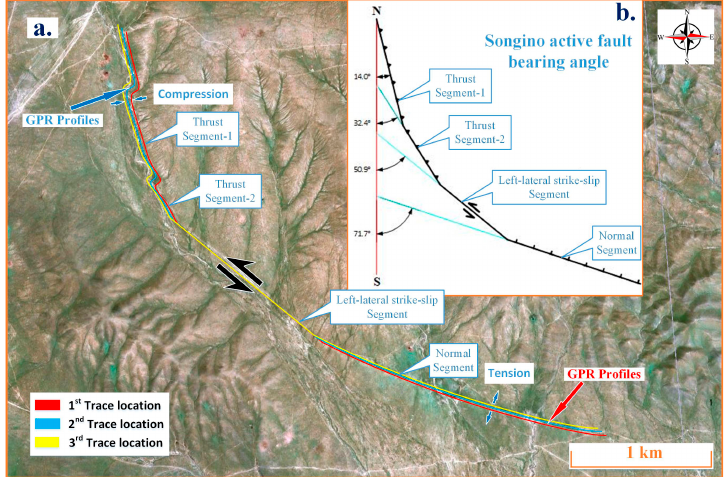
Figure 2. ( a ) Google Earth (2009) image showing the location of the Songino active fault. Red line indicates the 1st trace location, blue line represents 2nd trace location after the 1st seismic event, yellow one is the 3rd trace location after 2nd seismic event. ( b ) Modeling with time showing the variation in deformation process between NW (compressive), central (strike slip) and SE (extensive). The locations of GPR profiles discussed are indicated by blue (NW) and red (SE) arrows (modified from Tsend Ayaush, 2021 [15]).